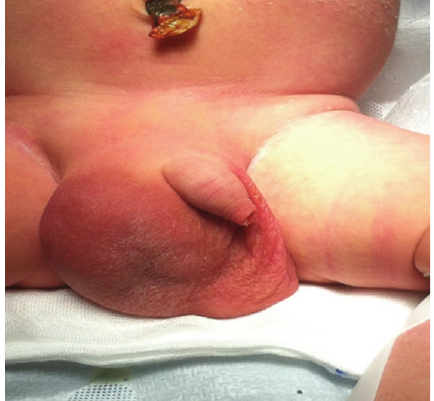
Figure 1: Echogenic scrotal mass ( 50 × 46 mm) with mixed echostructure and regular walls, containing few small echo-free cystic areas, in the right side.